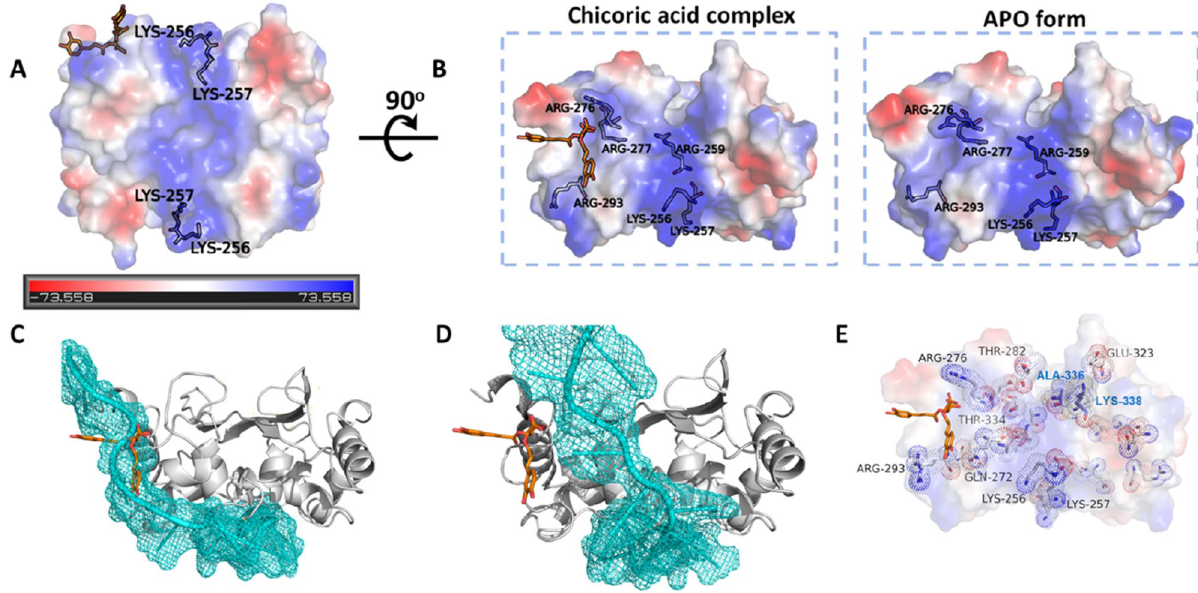
Figure 5. Chicoric acid (CA) binding to SARS-CoV-2 N protein CTD changes the topology and electrostatic character of the putative RNA-binding region with implications to RNA binding. ( A ) N protein CTD electrostatic potential with red and blue colors indicating negative and positive potentials, respectively (please refer to the electrostatic scale bar). The positively charged groove, formed by Lys256, Lys257, Lys259 Lys261 and Arg262, is thought to contribute for RNA binding. ( B ) The positively charged groove depicted in panel A extends towards the CA-binding pocket through Arg259, Arg276, Arg277 and Arg293. The eletrostacic potentials calculated from the CA-N protein CTD (PDB ID 7UXZ) and native N protein CTD (PDB ID 7UXX) crystal structures are shown. Figures and electrostatic potential were generated with Pymol (Schroedinger Inc.). ( C , D ) Structural alignment between the CTD-CA complex and a model of the N protein complexed with an RNA. The CTD chain (grey cartoon) complexed with CA (orange sticks) was superposed to two CTD chains from a N protein model complexed with RNA (cyan), which shows two distinct RNA-binding modes 33 . In the first alignment ( C ), the CA molecule fully occupies the predicted RNA-binding site, whereas in the second alignment ( D ), the CA site is near the RNA-binding site. In both scenarios CA should interfere in N protein binding to RNA. ( E ) CTD residues that underwent chemical shift changes (shown as sticks and dots) upon CA binding in the HSQC experiment, here mapped on the CTD crystal structure binding CA. Residues discussed in the text are labelled. Ala-336 and Lys-338 (labelled in blue) are form the second protomer of the CTD